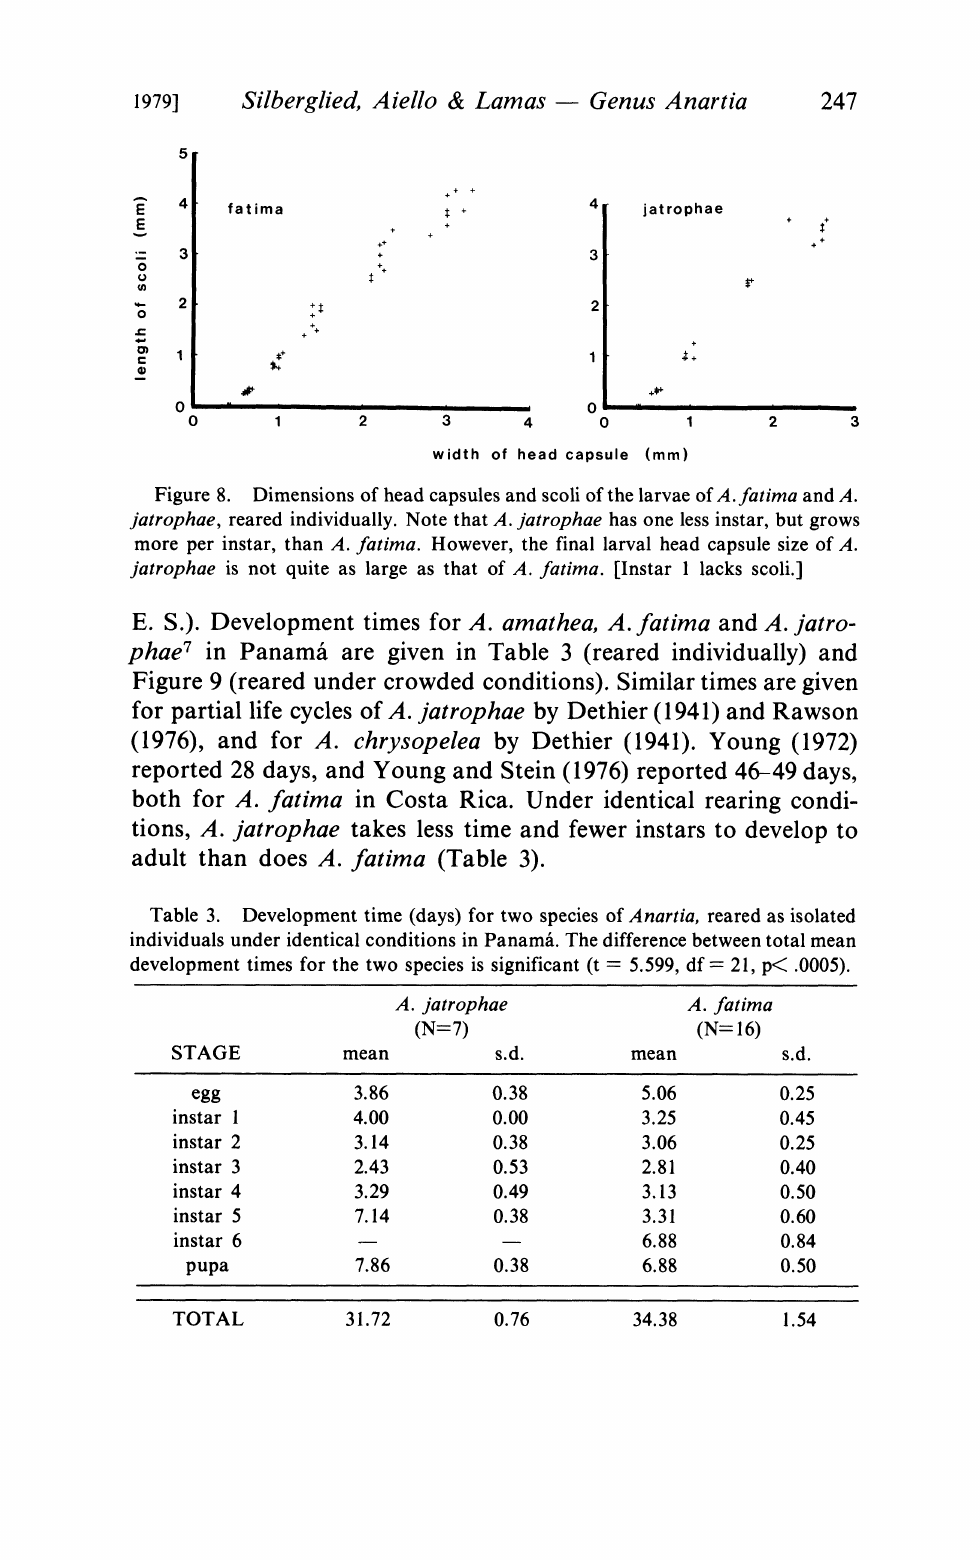
Table 3. Development time (days) for two species of Anartia, reared as isolated individuals under identical conditions in PanamL The difference between total mean development times for the two species is significant